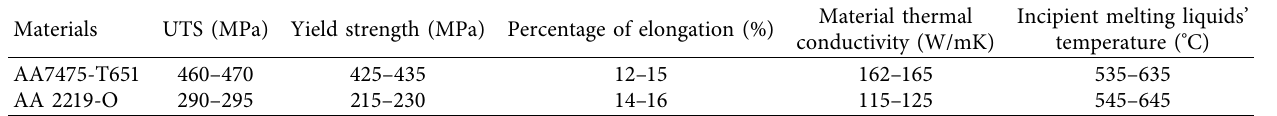
Table 2: AA7475 and AA2219: mechanical and thermal characteristics.